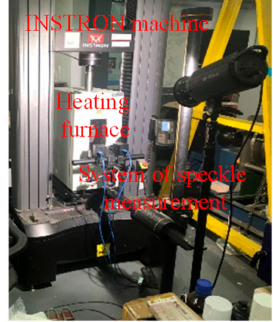
Figure 3. Uniaxial tension testing